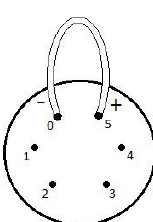
Figure 18 . The worldsheet con(cid:12)guration describing a 1-loop 4-point amplitude in 4d ambitwistor string